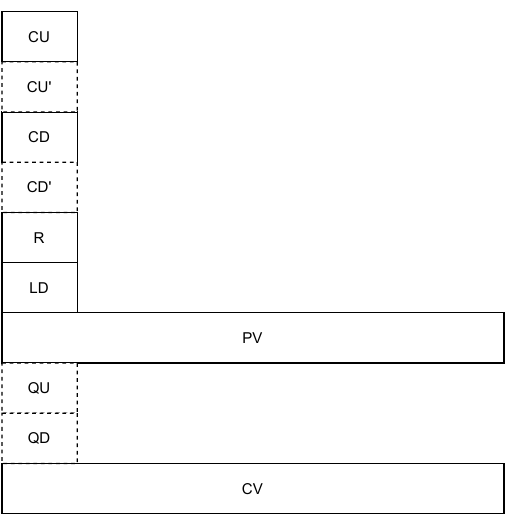
Figure 2. Minimum representation of a counter data